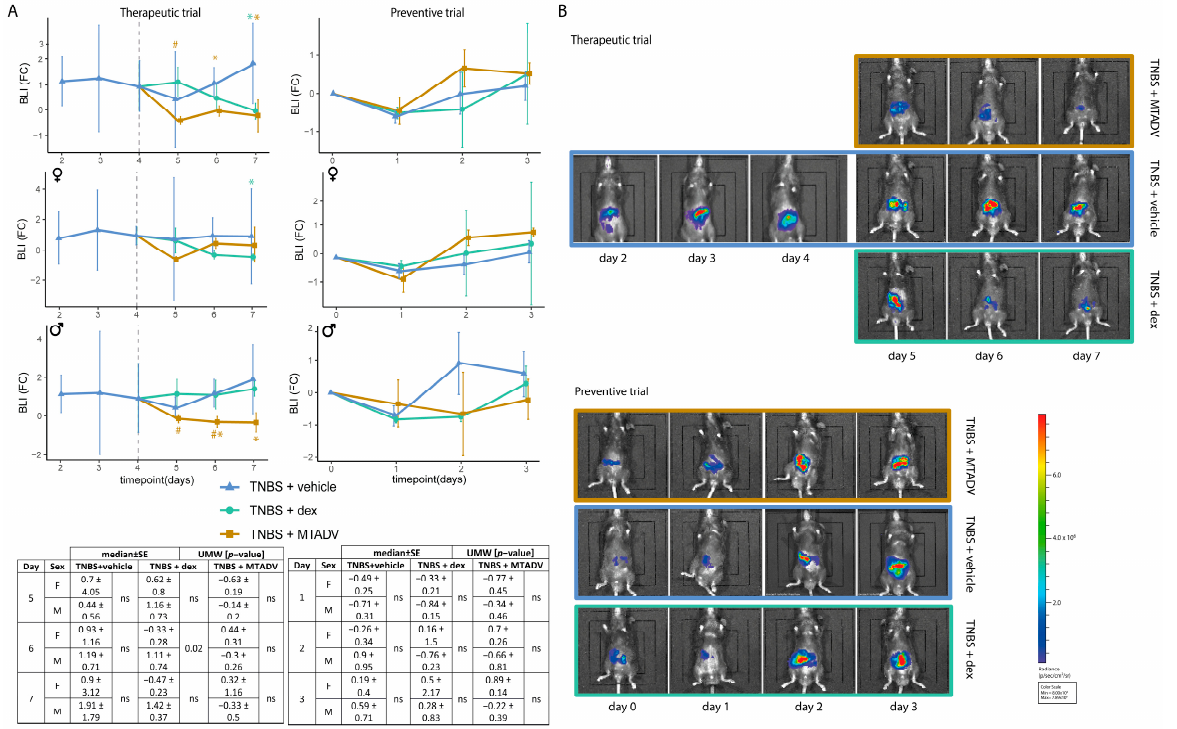
Figure 1. Bioluminescence evaluations in the follow ‐ up of the TNBS model. ( A ) BLI is represented as median FC ± SE in the follow ‐ up, represents therapeutic and preventive approaches, and is stratified by sex. Colors and dots denote treatment groups. Tables showing the statistical test (UMW) between sexes at each time point are given. ( B ) Graphical representation of bioluminescent images of each trial and treatment at each time point. Blue color represents the minimum pixel level, and red color the maximum pixel density. Asterisks indicate differences between treatments and vehicle administration, whereas pads mark differences between dexamethasone and MTADV treatments at each time point (Kruskal–Wallis with posthoc Dunn’s test). Significance levels: */ # 0.01 ≤ p ‐ value ≤ 0.05. BLI, bioluminescence intensity; dex, dexamethasone; F, female; FC, fold ‐ change; M, male;